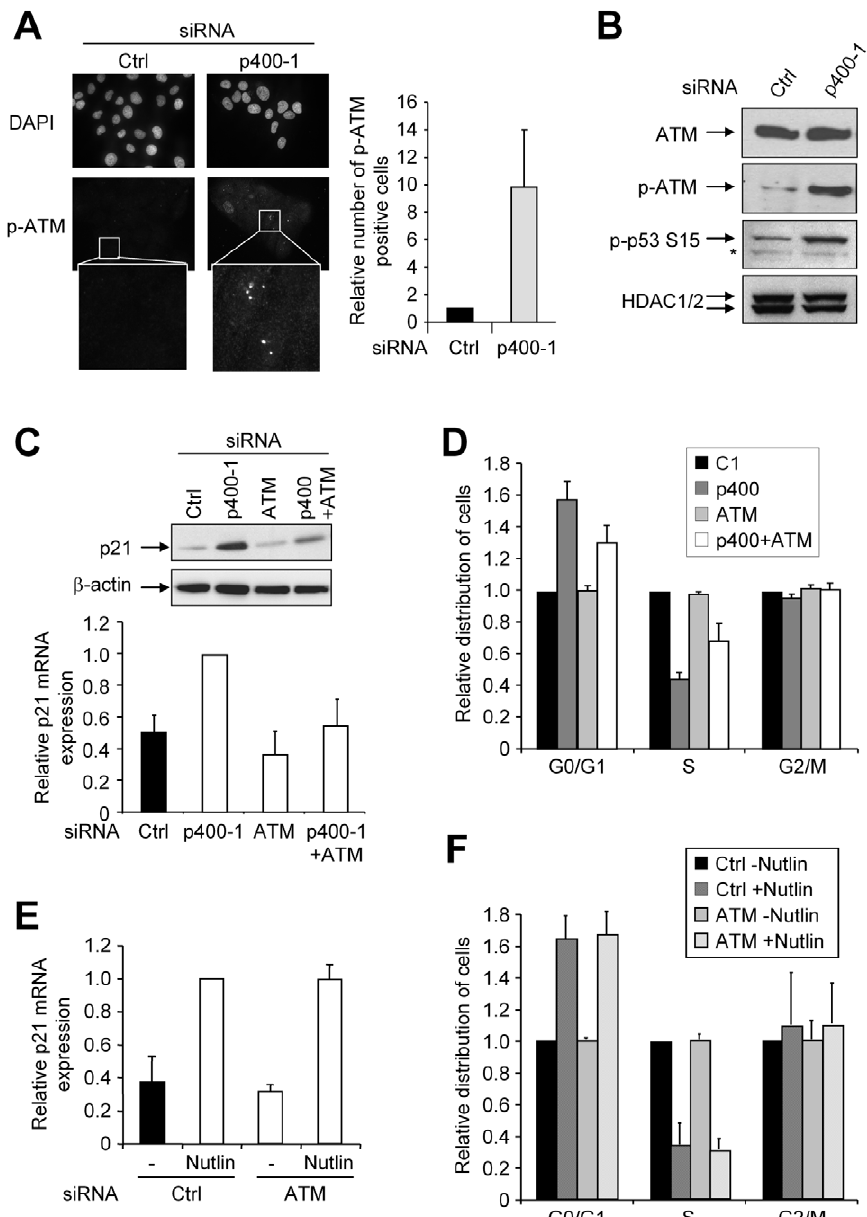
Figure 4. p400 depletion leads to the induction of a DNA damage response. (A) U2OS cells were transfected using the indicated siRNA. 48 h after transfection, cells were fixed and subjected to DAPI staining and an immunofluorescence analysis using anti-phosphoATM antibodies. Representative fields are shown on the left and quantification using ImageJ software on the right (the mean and SD from 3 independent experiments are shown (after standardisation relative to 1 for cells transfected with the control siRNA)). (B) Same as in (A), except that total cell extracts were prepared and analysed by western blot using anti-ATM, anti-Phospho-ATM, anti-Phospho-p53 and anti-HDAC1/2 (as a loading control) antibodies. Note that the asterisk indicates non-specific bands in the Phospho-p53 panel. (C) U2OS cells were transfected using the indicated siRNA alone or in combination as indicated. The total amount of siRNA in the transfection was kept constant using the control siRNA. 48 h later, total cell extracts were prepared and analysed by western blot using anti-p21 and anti- b -actin (as a loading control) antibodies (upper panel). Total RNA were also prepared, reverse transcribed and cDNA were then analysed for p21 and GAPDH expression by Q-PCR. The amount of p21 cDNA was divided by the amount of GAPDH cDNA and calculated relative to 1 for cells transfected using the control siRNA (lower panel). The mean and SD from 5 independent experiments are shown. (D) Same as in (C), except that cells were harvested and analysed for cell cycle distribution by flow cytometry. The proportion of G0/G1, S and G2/M cells in each condition were quantified relative to 1 for cells transfected by the control siRNA. The mean and SD from 3 independent experiments are shown. (E) U2OS were transfected using the indicated siRNA and treated with Nutlin-3. 48 h later, total RNA were prepared, reverse transcribed. cDNAs were then analysed for p21 and GAPDH expression by Q-PCR. The amount of p21 cDNA was divided by the amount of GAPDH cDNA and calculated relative to 1 for cells transfected using the control siRNA and treated with nutlin. The mean from two independent experiments is shown. (F) Same as in (E), except that cells were harvested and analysed for cell cycle distribution by flow cytometry as described in (D). The mean from two independent experiments is shown.